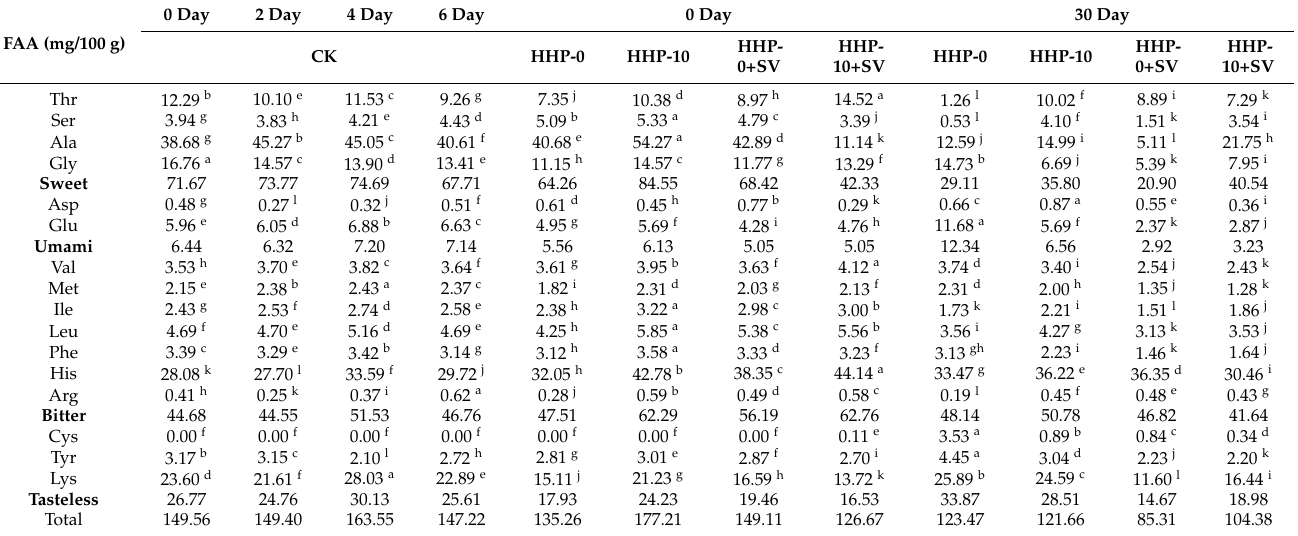
Table 3. Effects of different treatments on the free amino acids in largemouth bass during